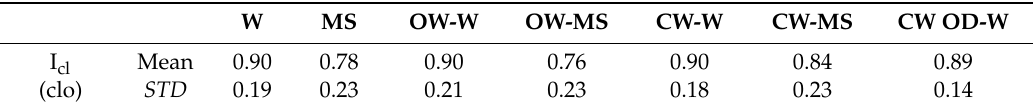
Table 7. Mean values of occupants’ clothing insulation obtained during the field measurements related to seasons and windows’ and doors’ operation.